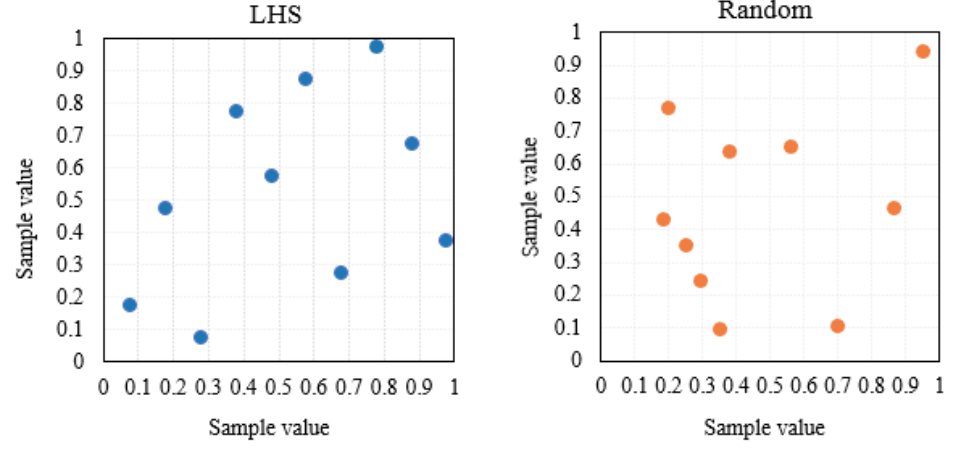
Figure 12. Comparison of LHS and Random sampling.